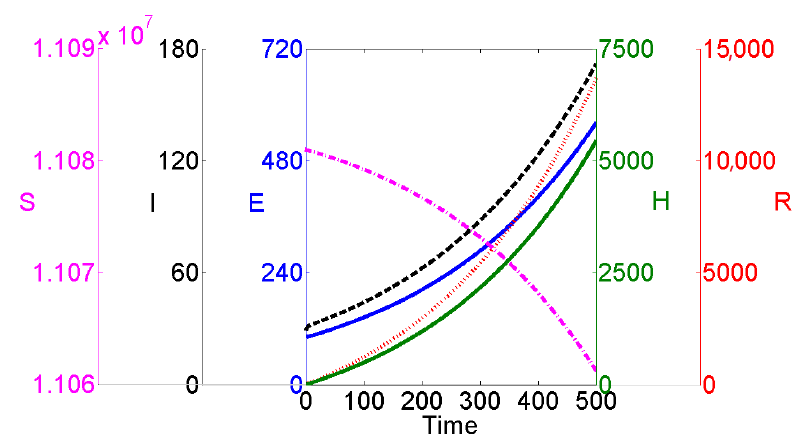
Figure 9. The dynamics of the model equation for the endemic steady state with R 0 >